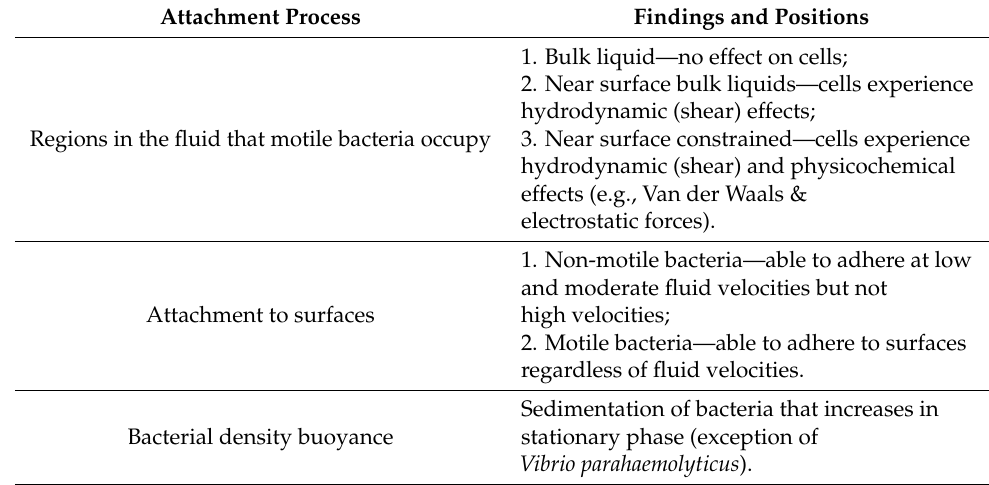
Figure 2. Schematic diagrams of microbial contamination and resistance in industrial piping networks. Table 1. Summary for the cell attachment mechanism and